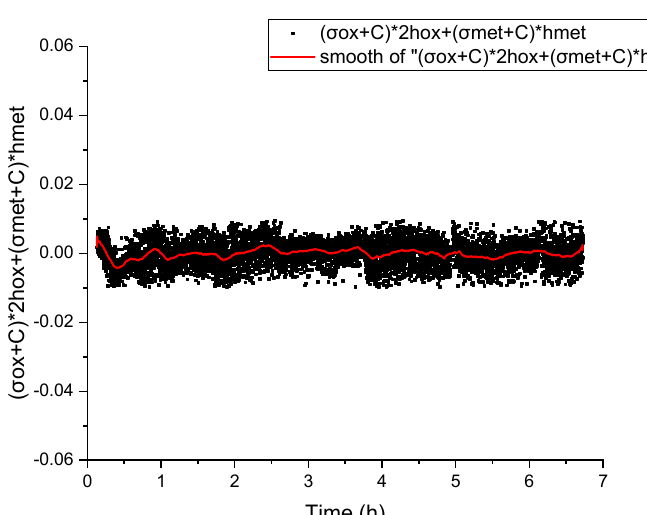
Figure 17. Plot of the mechanical balance equation taking into account the offsets values for the R0.58 sample.